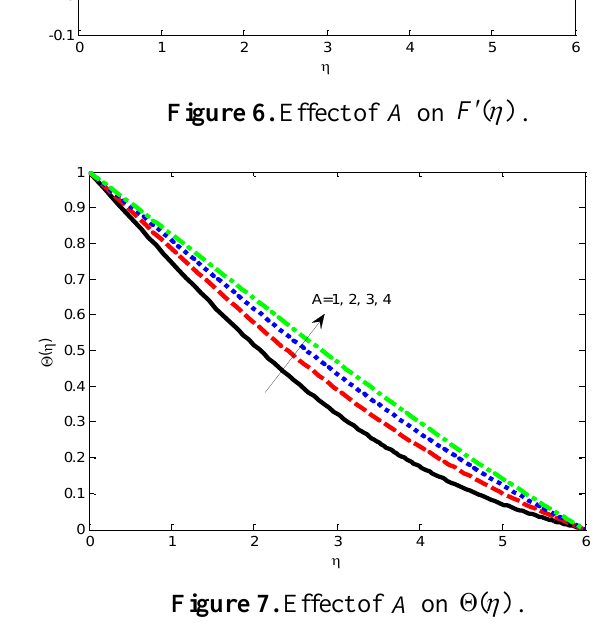
Figure 7. Effect of A on ( )  .